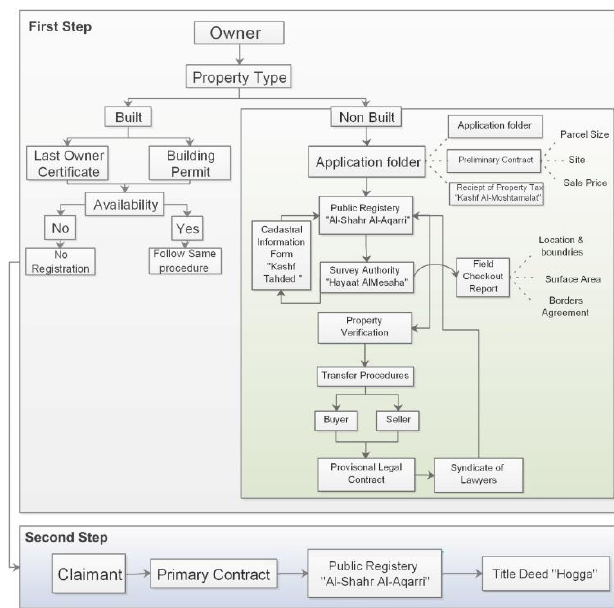
Figure 1: Legalizing of Land Transfer Property - Source: